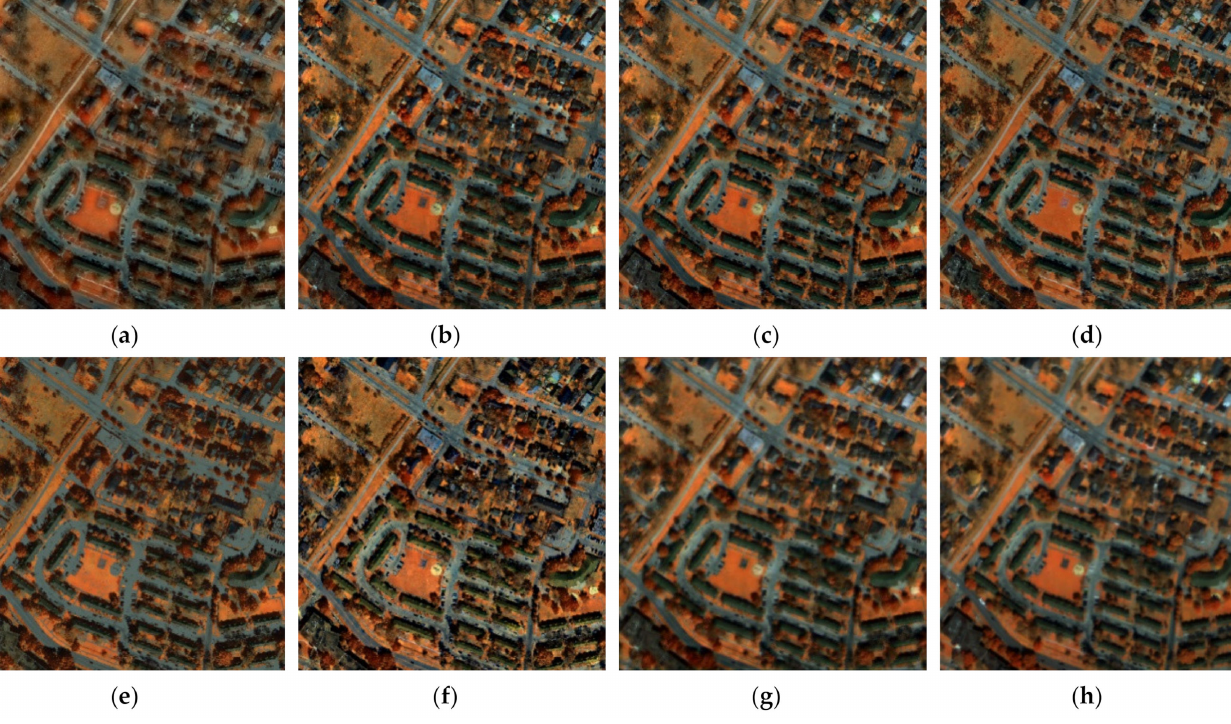
Figure 10. Results of Houston 2018 dataset with real multispectral images. ( a ) results of GSA; ( b ) results of SFIMHS; ( c ) results of GLPHS; ( d ) results of CNMF; ( e ) results of ICCV15; ( f ) results of HySure; ( g ) ours results; ( h ) Ground